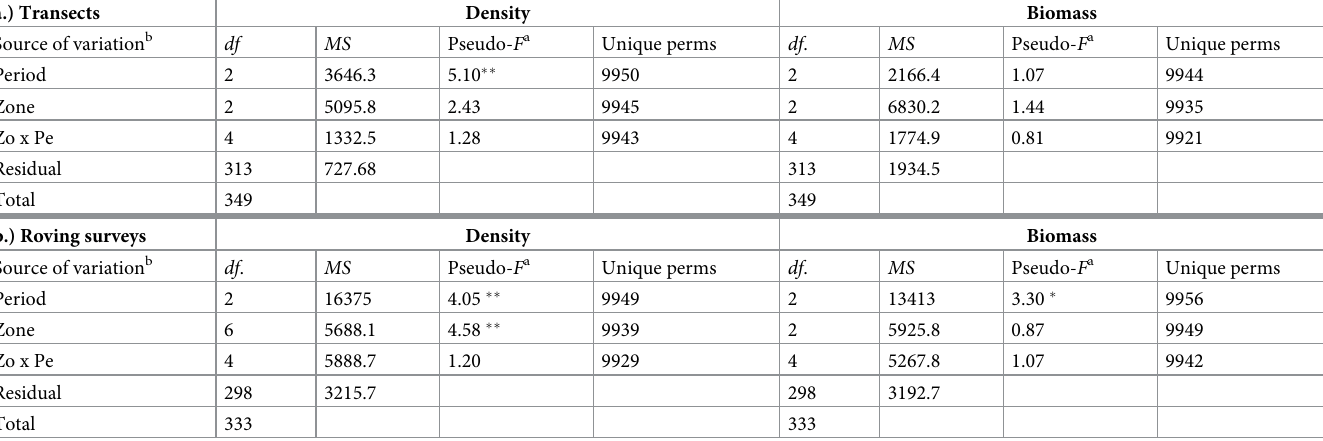
Tests conducted on Bray-Curtis dissimilarities of root-transformed biomass and density from belt transects (a), and roving surveys (b), conducted in the MNTZ in 2005, 2010, and 2017. a Level of significance: